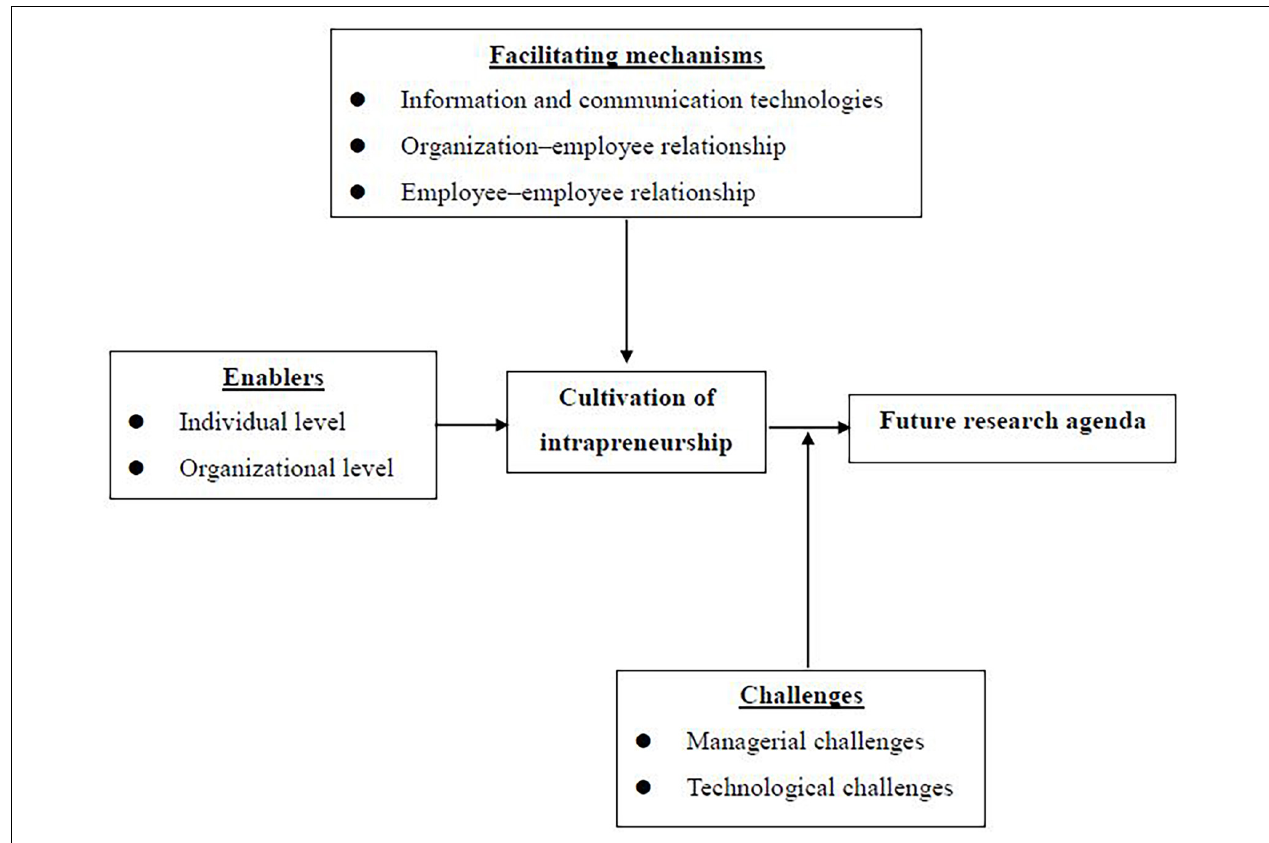
FIGURE 1 | Conceptual framework for cultivation of